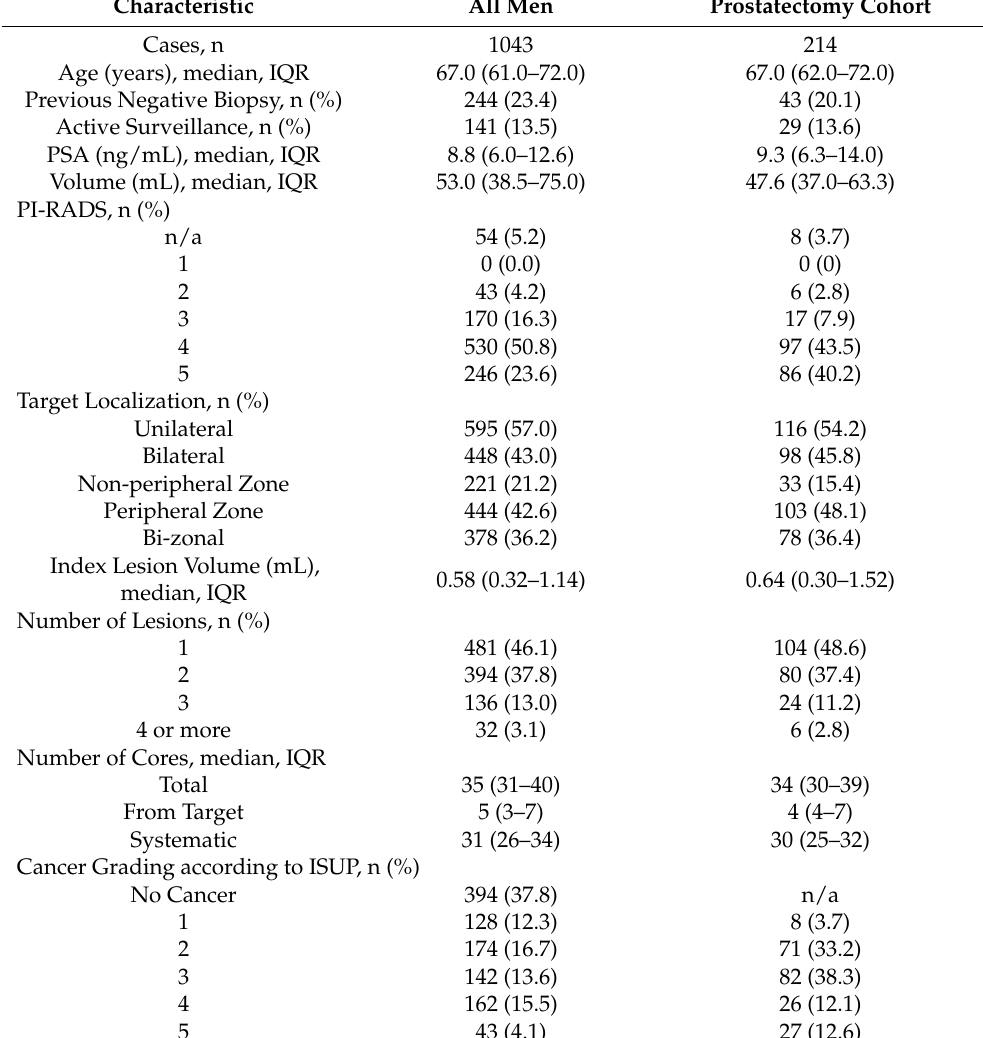
Table 1. Baseline Characteristics and Cancer Detection Rates. IQR—interquartile range; PSA—prostate specific antigen; PI-RADS—Prostate Imaging Reporting and Data System; ISUP—International Society of Urological